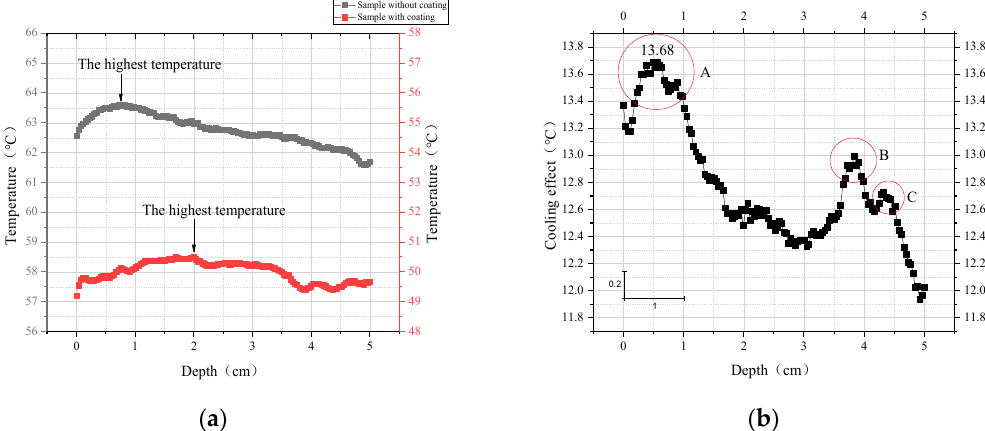
Figure 11. Analysis of internal temperature data. ( a ) Internal temperature changes of the coated and uncoated samples; ( b ) cooling e ff ect of the